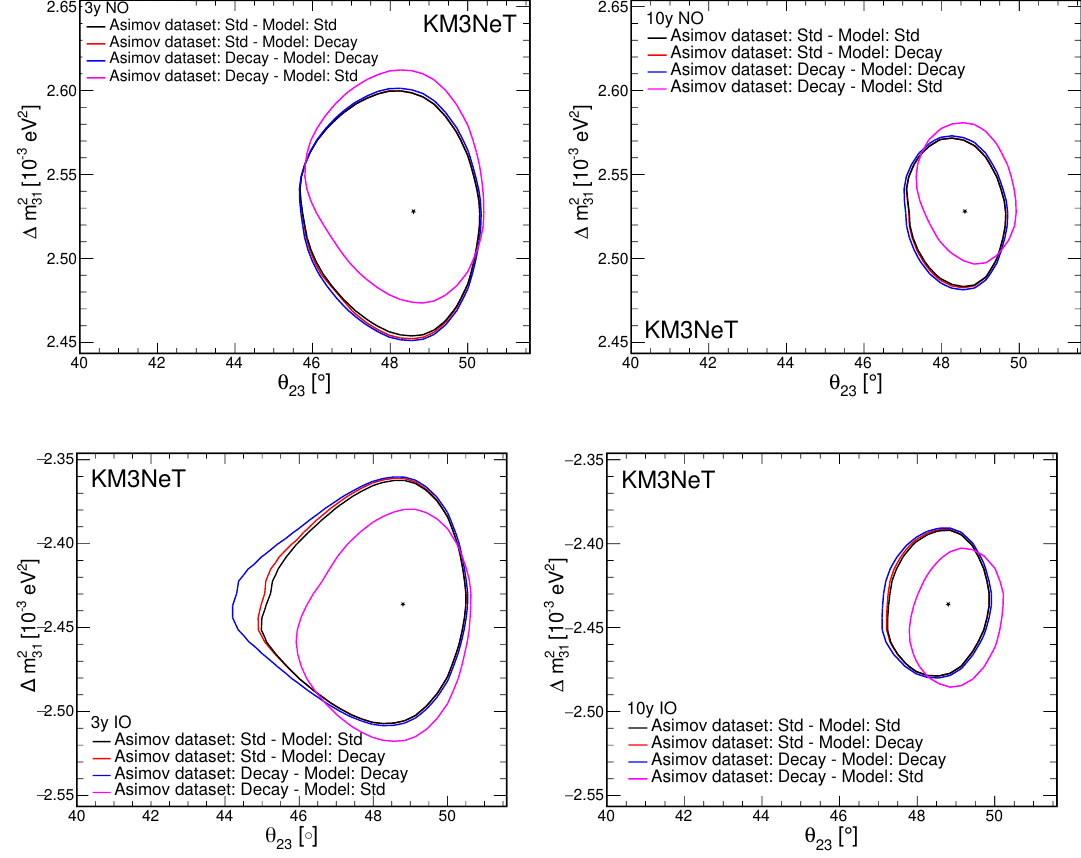
Figure 12. KM3NeT/ORCA 90% CL sensitivity contour plots to the oscillation parameters θ 23 and ∆ m 2 for 3 (left) and 10 (right) years of data taking assuming NO (top) or IO (bottom) for four 31 cases: standard oscillations in both the Asimov dataset and model (black), standard oscillations in the Asimov dataset but using a decay model in the fit (red), Asimov dataset assuming a decay scenario ( α 3 = 1 . 22 × 10 − 5 eV 2 ) and decay model in the fit (blue), and Asimov dataset assuming a decay scenario ( α 3 = 1 . 22 × 10 − 5 eV 2 ) but assuming standard oscillations in the model to fit (magenta). True values used to simulate the Asimov dataset are marked with